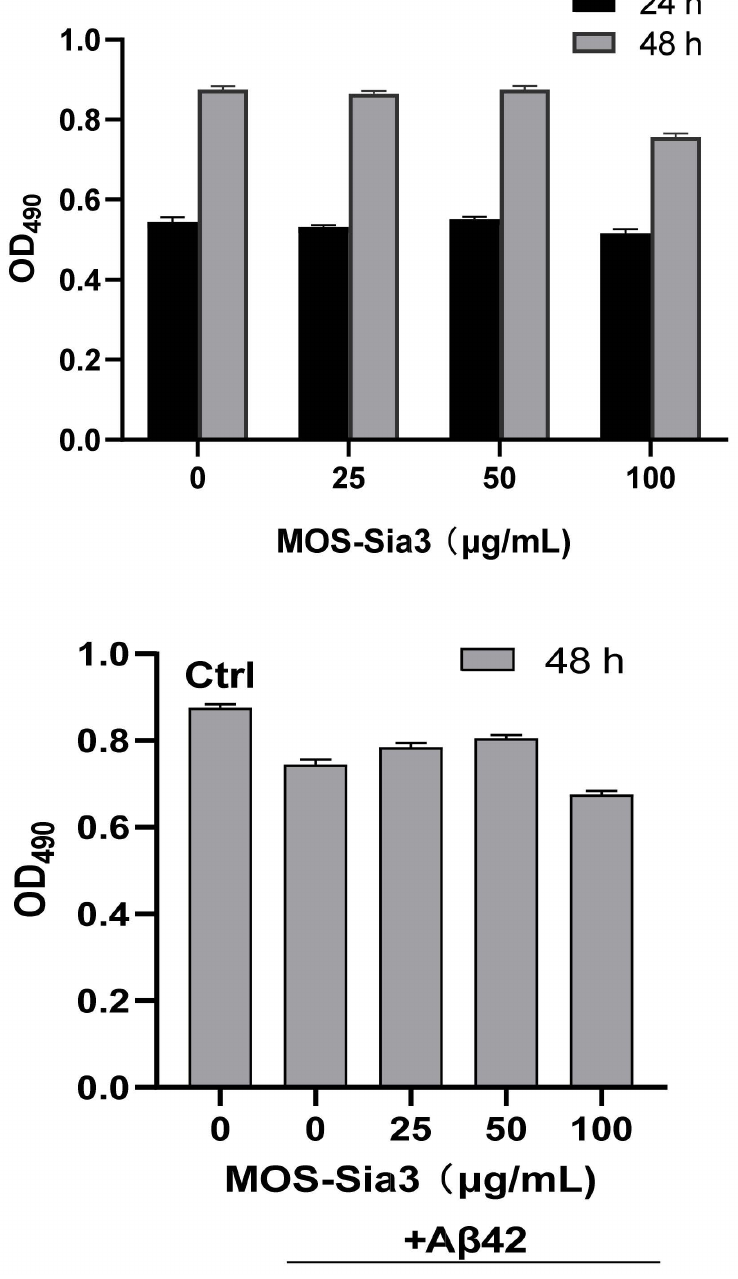
Figure 5. Effect of MOS-Sia3 on the cell growth of BV-2. Data are shown as the mean ± SD of